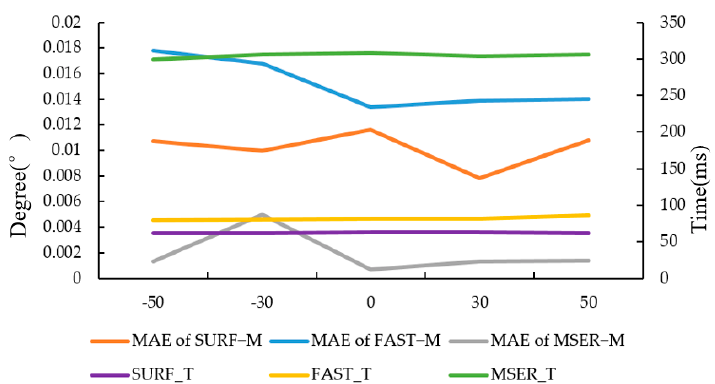
Figure 8. The result of FAST − M, SURF − M and MSER − M. MAE means mean absolute error, while FAST_T, MSER_T and SURF_T mean the running times of the algorithms, respectively.